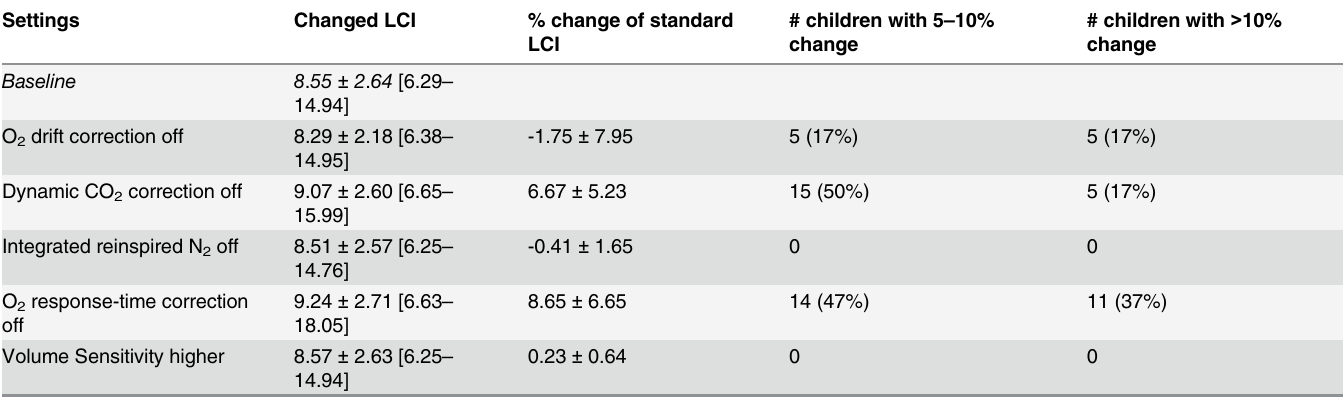
Table 7. Effect size of the change in LCI after reanalysis with different algorithms for signal processing and detection limits.